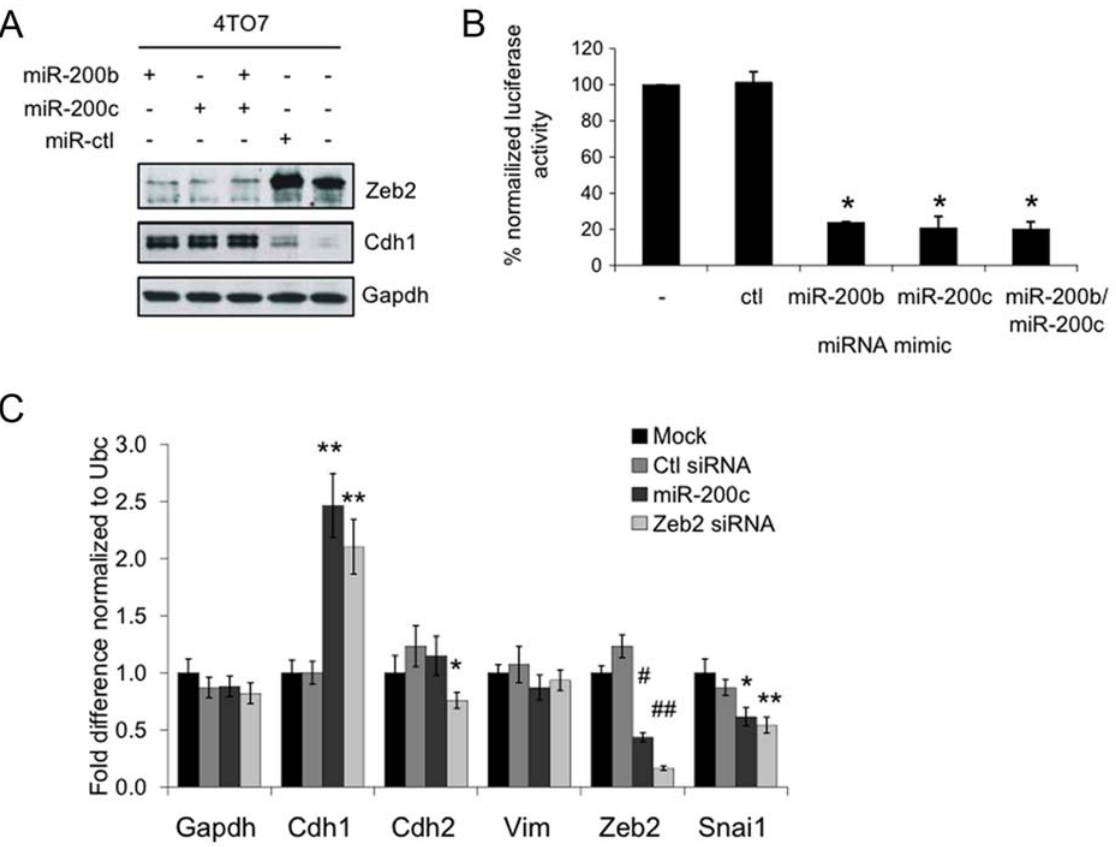
Figure 3. Over-expression of miR-200 in 4TO7 cells down-regulates Zeb2 expression, resulting in increased E-cadherin. (A) Zeb2 expression decreases and E-Cadherin (Cdh1) expression increases, analyzed by immunoblot relative to Gapdh, after transfection of 4TO7 cells with miR- 200b and/or miR-200c. (B) miR-200 regulates the Zeb2 3 9 -UTR in a luciferase reporter assay. 4TO7 cells were co-transfected with the Zeb2 3 9 -UTR luciferase plasmid or a control vector and either the control(ctl), miR-200b and/or miR-200c miRNA mimics. The meanand standard deviation of therelative luciferase activity, normalized relative to that of mock-transfected cells, from 3 independent experiments is shown (*p , 0.0002). (C) Comparison of mRNA levels of epithelial and mesenchymal markers (Cdh1, Cdh2, vimentin (Vim), Zeb2, and Snai1) in 4TO7 cells transfected with miR-200c mimic or an siRNA targeting Zeb2 (Zeb2 siRNA) or control (ctl) siRNA, analyzed by qRT–PCR normalized to the housekeeping gene Ubc. miR-200c expression increased Cdh1 mRNA, an epithelial marker, and decreased Snai1 and Zeb2, mesenchymal markers, but had no effect on N-cadherin (cdh2) or vimentin (Vim). Knocking down Zeb2 had a similar effectas expressing miR-200c, except that Cdh2 mRNA was also significantly suppressed by reducingZeb2.Mean and standard deviationfor3 independent experiments are shown relative to the results for mock-transfected cells (*,p , 0.05, **,p , 0.01, ***,p , 0.005, # ,p , 0.001 and ## ,p ,